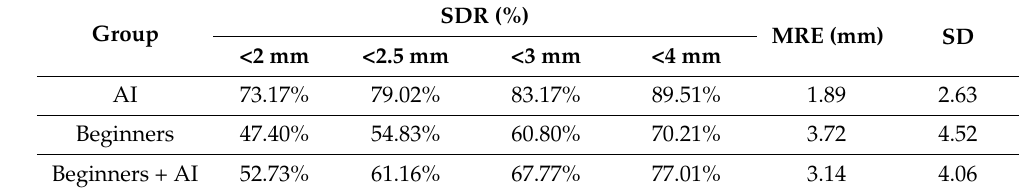
Table 4. Quantitative comparison by average successful detection rate and mean radial error.